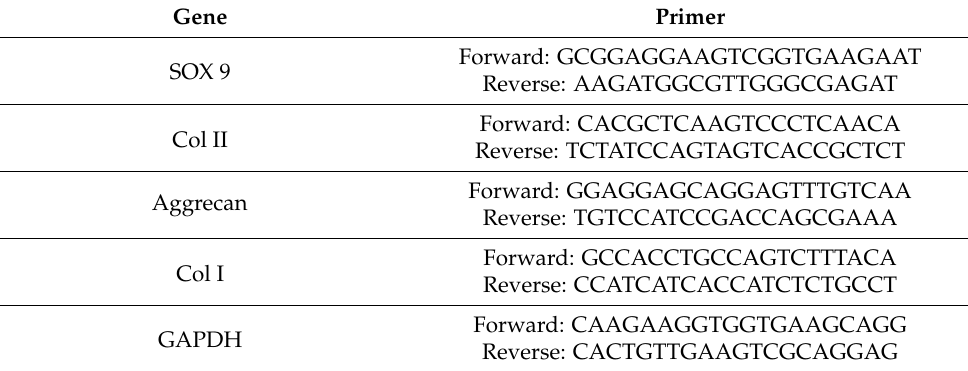
Table 1. The Primer used in this study.